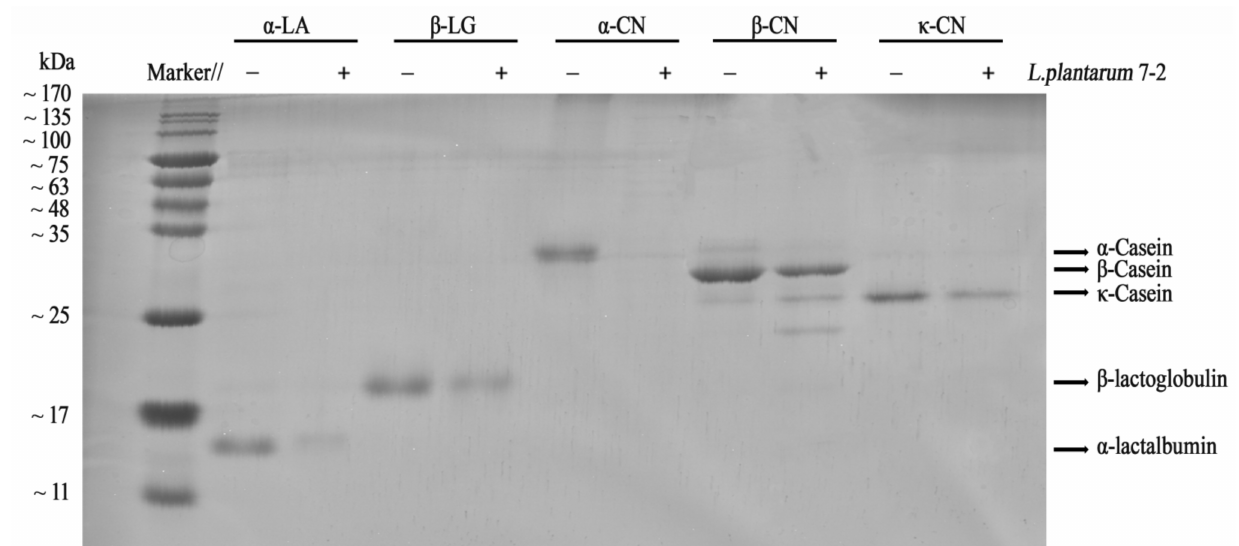
Figure 5. Sodium dodecyl sulfate-polyacrylamide gel electrophoresis (SDS-PAGE) of milk protein treated with L. plantarum 7-2 for 0 h and 18 h. Lanes marked ‘ − ‘ represents the standard protein of α -LA, β -LG α -CN, β -CN, and κ -CN, respectively, which have not been fermented by L. plantarum 7-2. ‘+’ represents the standard protein of α -LA, β -LG, α -CN, β -CN, and κ -CN, that have been fermented for 18 h by L. plantarum